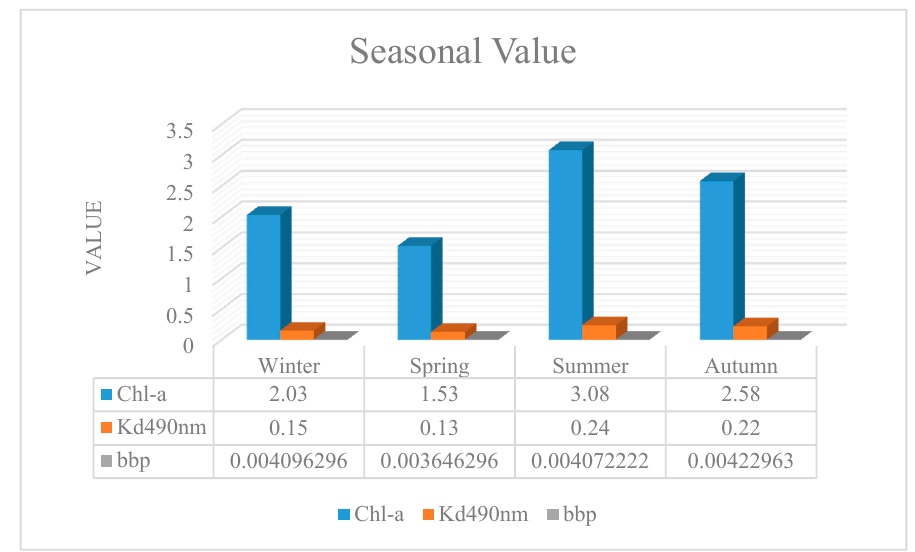
Figure A12. Seasonal variability of bio-optical parameters in 1998-2015.